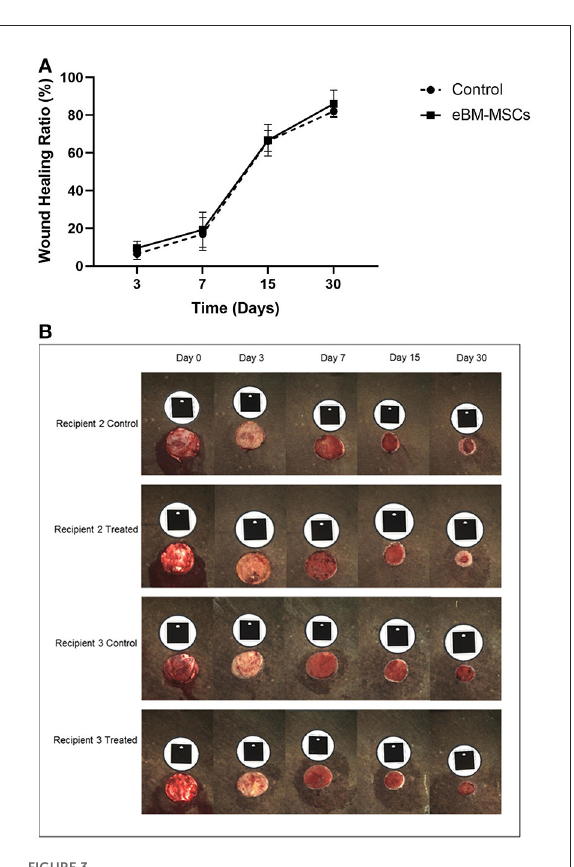
FIGURE3 Wound healing in recipient horses. (A) Graph showing percentage changes in wound healing in all horses as a function of time. The wound area is measured in mm 2 at time 0, and subsequently at days 3, 7, 15 and 30. The area at each time point is then compared to the area at time 0. Finally, the % wound healing is expressed and plotted graphically. (B) Representative digital images of the 4cm diameter wounds in the recipients 2 and 3 at various time points are shown. The black tag above each wound is the marker and is recognized by the camera to ensure a consistent and reproducible angle when the image is taken. Note the significant amount of epithelialized region of the wound in the Recipient 2 treated